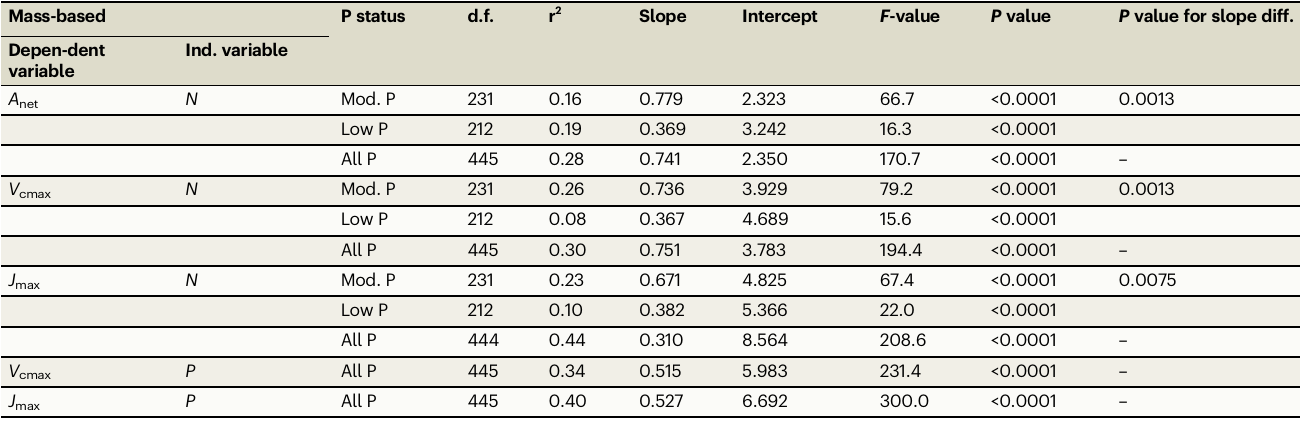
Slope diff.isrespectivetoP status (lowP versusmoderate P concentration; see text), d.f.indicates thedenominator degreesoffreedom.Theequivalentarea-basedresults areshown in the standardized majoraxis analysisinSupplementaryTable 3. Analyses were doneusingordinaryleast-square (OLS)regressionsfordifferentP statuslevelsandallPlevelstogether( ‘ AllP ’ ).Boththedependentandindependent( ‘ Ind. ’ )variables fortheleast- squaresregressionsarenaturallogarithm-transformed.ThedifferencebetweenthelowandmoderatePstatusgroupsarede fi nedinthetextaccordingtoaP mass thresholdof0.92mgg − 1 ,andthe differences inslopes ( ‘ slopediff. ’ ) weretested using separate-slopesanalyses.